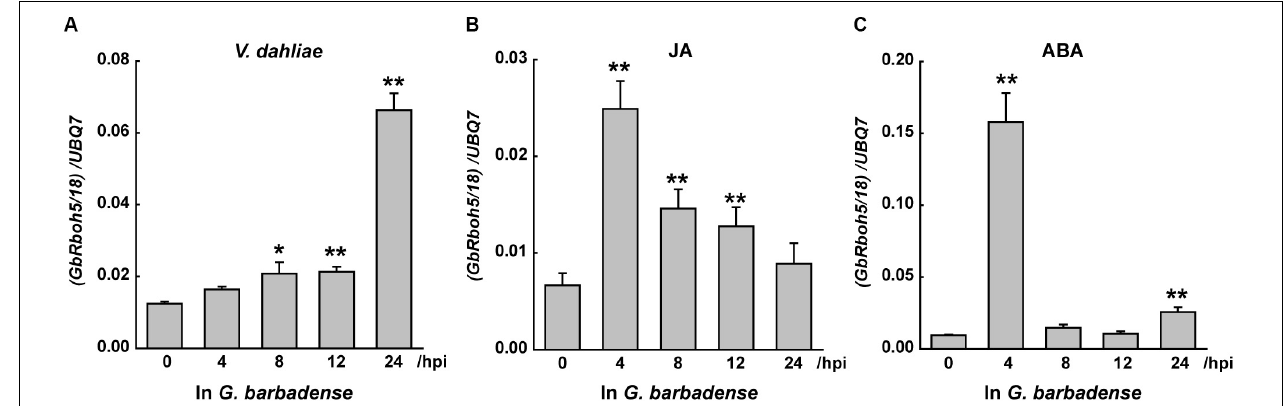
FIGURE 5 | GbRboh5/18 are the main functional genes of CladeD in G . barbadense . Quantitative analyses of GbRboh5/18 expression levels in “Xinhai15” cotton plant leaves inoculated with (A) V . dahliae , (B) jasmonic acid, and (C) abscisic acid. Total RNAs were extracted from leaves of 3-week-old seedlings at 0, 4, 8, 12, and 24 h post-inoculation. The experiments were repeated three times, with similar results. The values are the means ± SD for three technical replicates. Transcript levels of each gene couple were first normalized to UBQ7 . Asterisks indicate significant differences compared with 0 h under same treatment (* p < 0.05; ** p < 0.01, Student’s t -test).